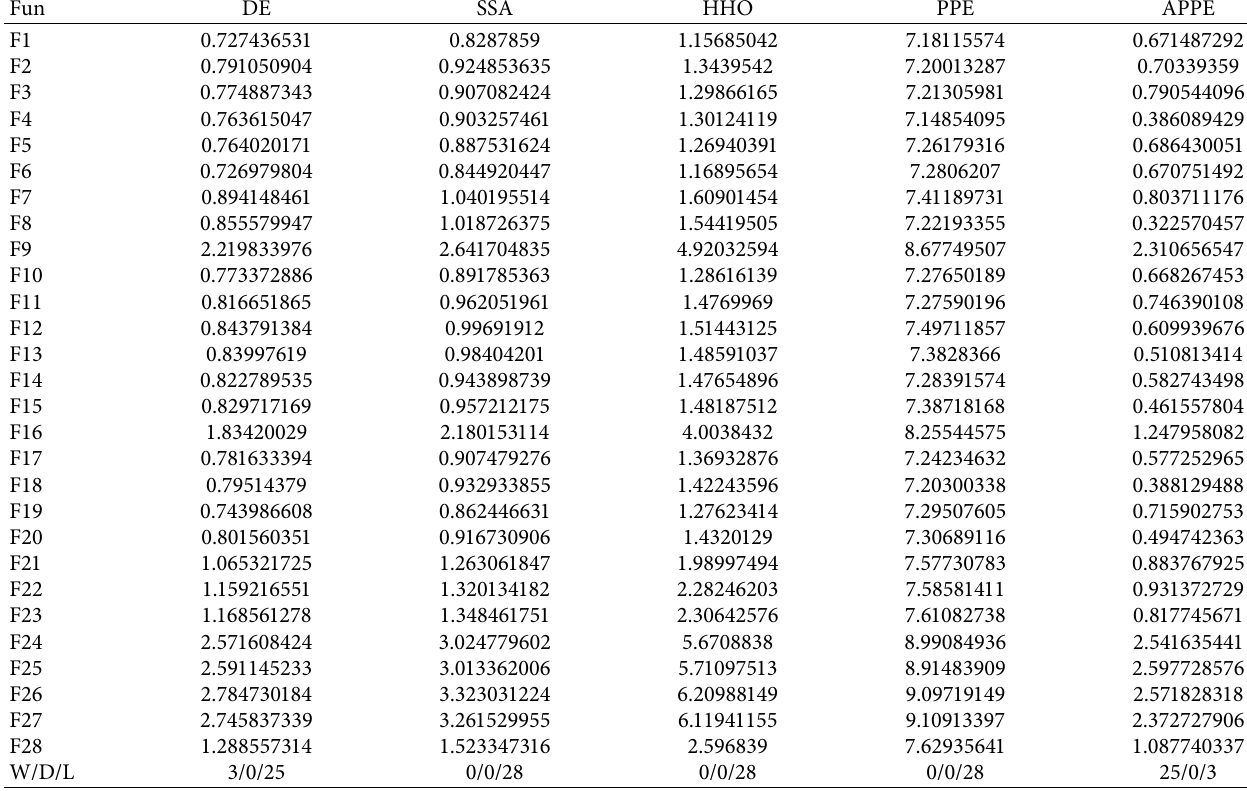
Table 5: Comparison of the average running time result of 51 runs on 10D in 28 benchmark functions.